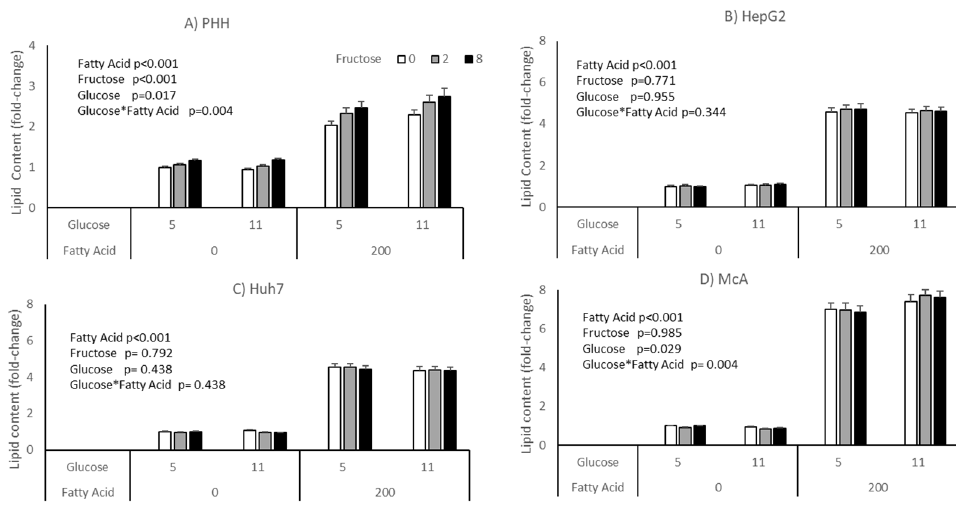
Figure 2. Impact of glucose, fructose and fatty acids on lipid accumulation in different cell types; ( A ) PHH, ( B ) HepG2, ( C ) Huh7, ( D ) McA. Values for PHH represent the mean (±SEM) of data from 5 individual livers (each experiment performed on 2 separate plates with 5 replicates per plate, total replicates = 50). Values for other cell lines (represent mean of data from 3 individual experiments (with similar replication as PHH, total replicates = 30/cell type). Data was analysed by 3-way ANOVA (glucose*fructose*fatty acid) with blocking for liver (for PHH) and plate for all cell types. No significant interactions were seen between Fructose*Glucose, Fatty Acids*Fructose or Fatty